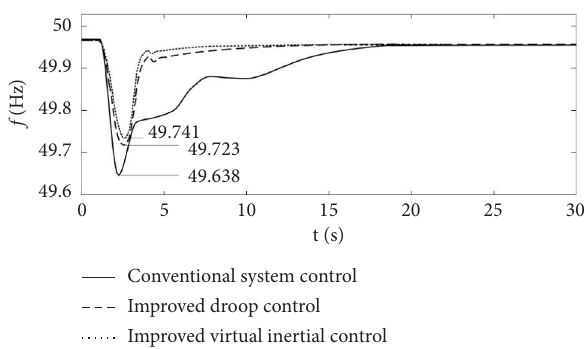
Figure 7: Battery energy storage participates in system frequency